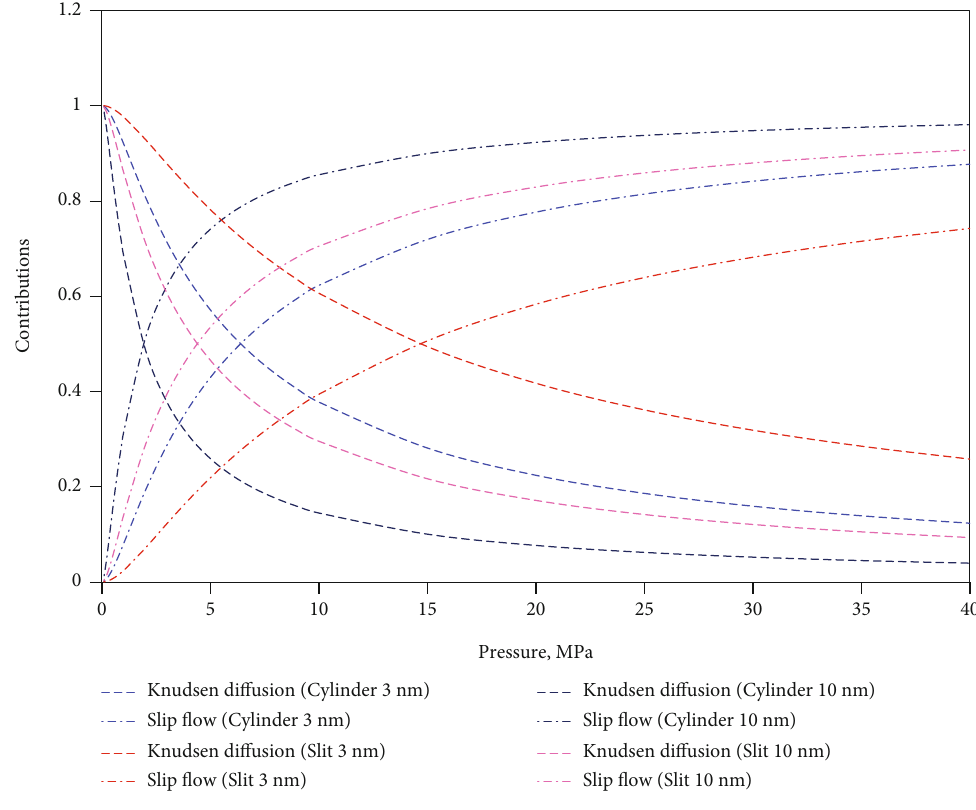
Figure 7: Contribution of di ff erent gas transport mechanisms.